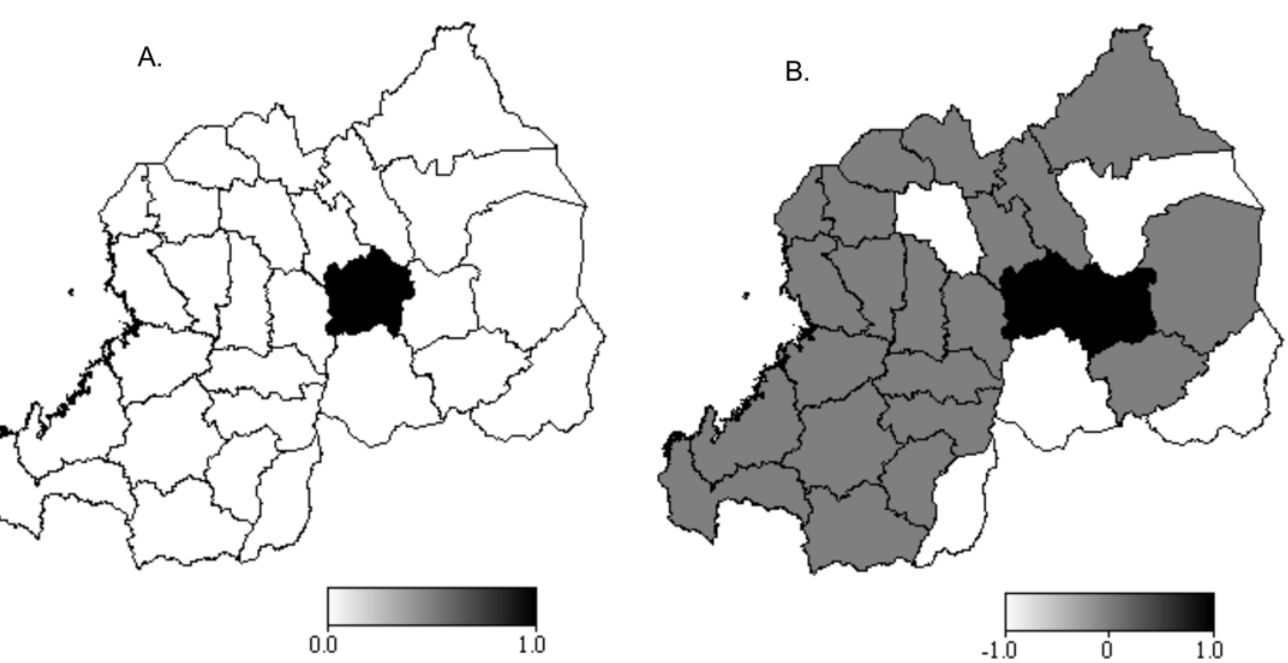
Fig 3. Maps of 95% (A) and 80% (B) posterior probabilities for the unadjusted total spatial effects.